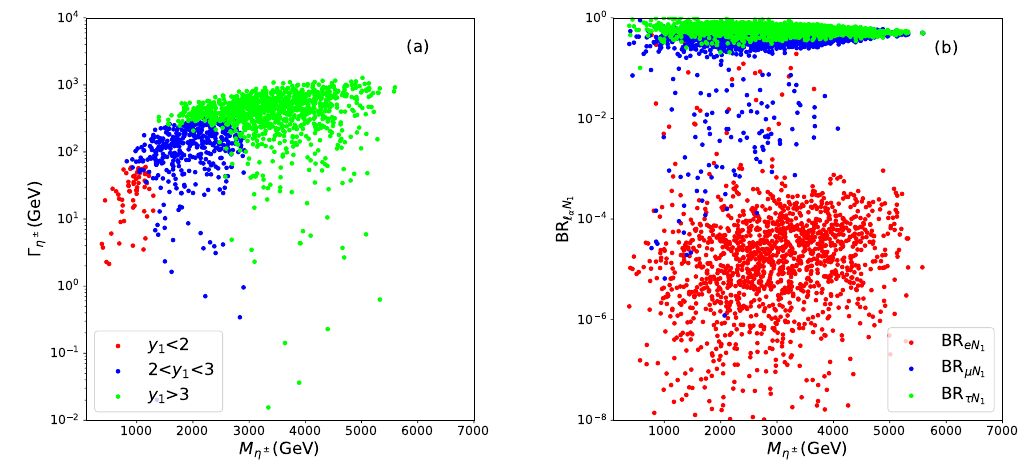
Figure 6 . Left: the total decay width of charged scalar η ± . Right: the branching ratios of charged scalar η ±